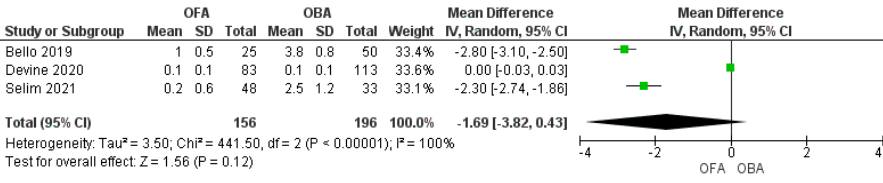
Figure 7. Forest plot of mean difference of pain at 48 h comparing opioid − free anesthesia and opi- oid − based anesthesia [16,17].